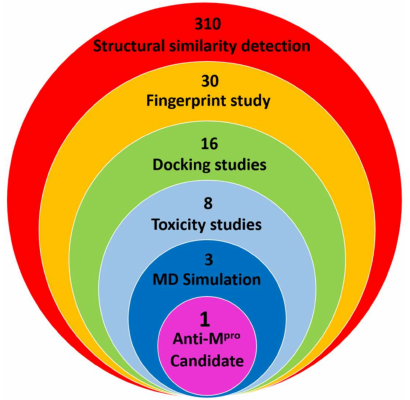
Figure 1. The utilized computational